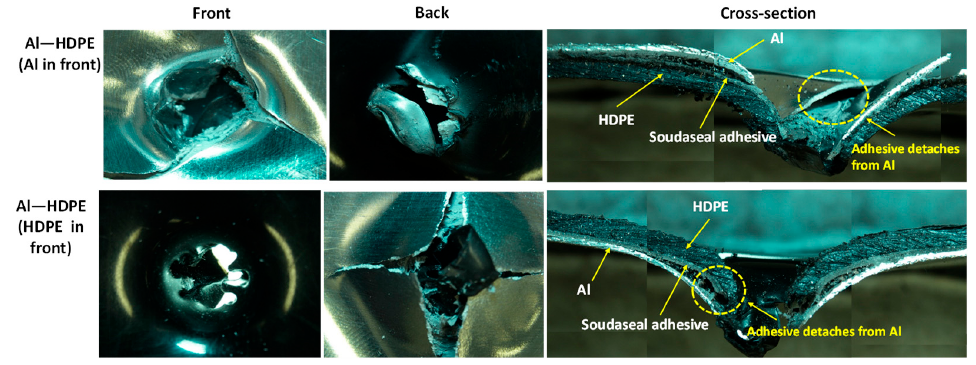
Figure 8. Failure modes of bilayer laminates under the hemispherical indenter.